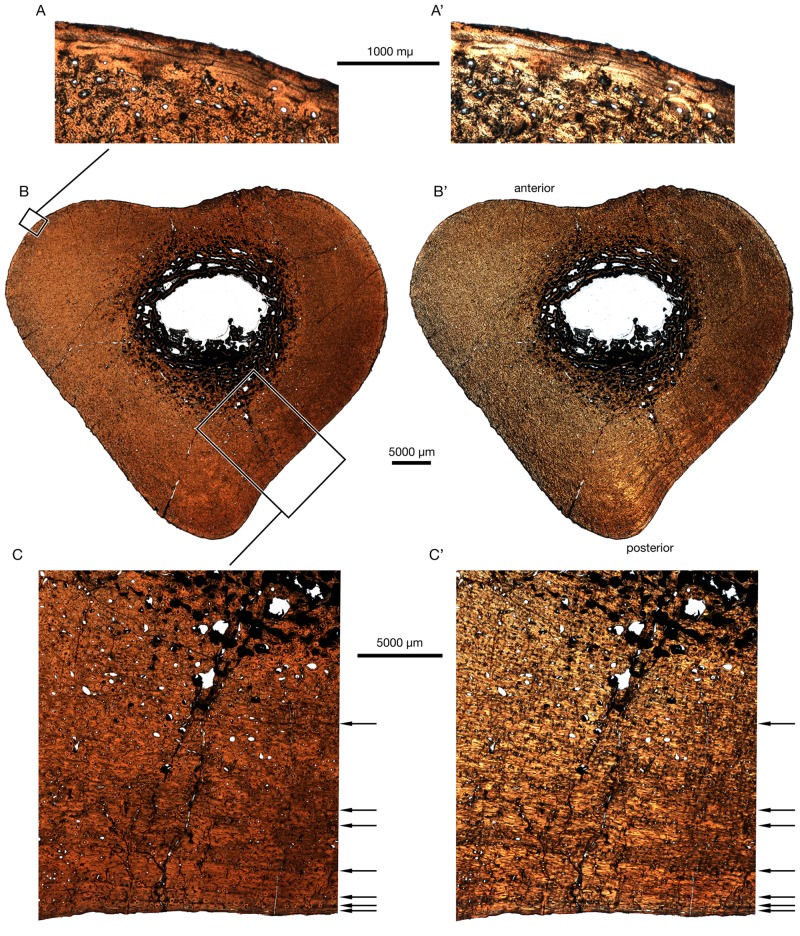
Osteohistology of the fibula in Spiclypeus shipporum gen et sp. nov. (CMN 57081) in transverse section under normal (left) and polarized (right, prime designations) light.(A) Close-up of inset in (B) showing the periosteal surface on the anterior side of the bone and the development of poorly vascularized, highly organized primary bone tissue of the external fundamental system; (B) full transverse section of fibula; and (C) close-up of inset in (B) exhibiting the least amount of remodelling and showing growth marks (indicated by arrows) in the primary bone tissue.